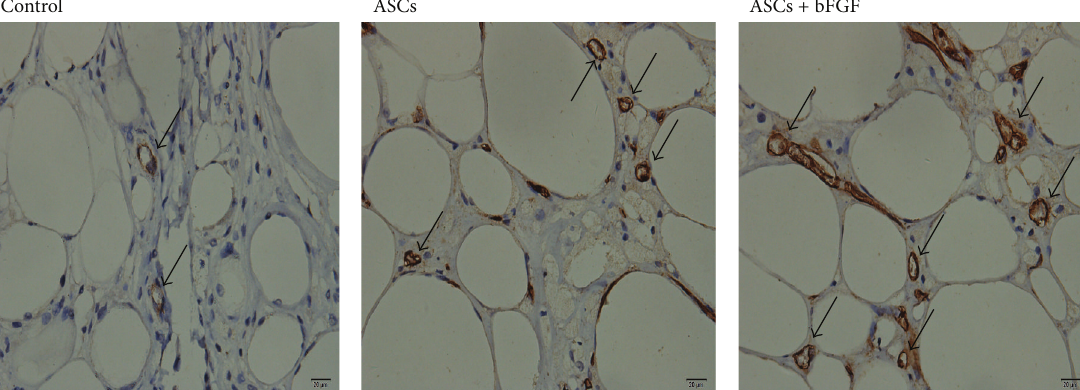
Figure3:VascularizationinthefatgraftsasevidencedbyfactorVIIIimmunohistochemistry(magnification × 400).FewerfactorVIIIpositive blood vessels were observed in control grafts while compared to ASCs group, and bFGF further promoted blood vessel generation while compared to grafts received ASCs alone.